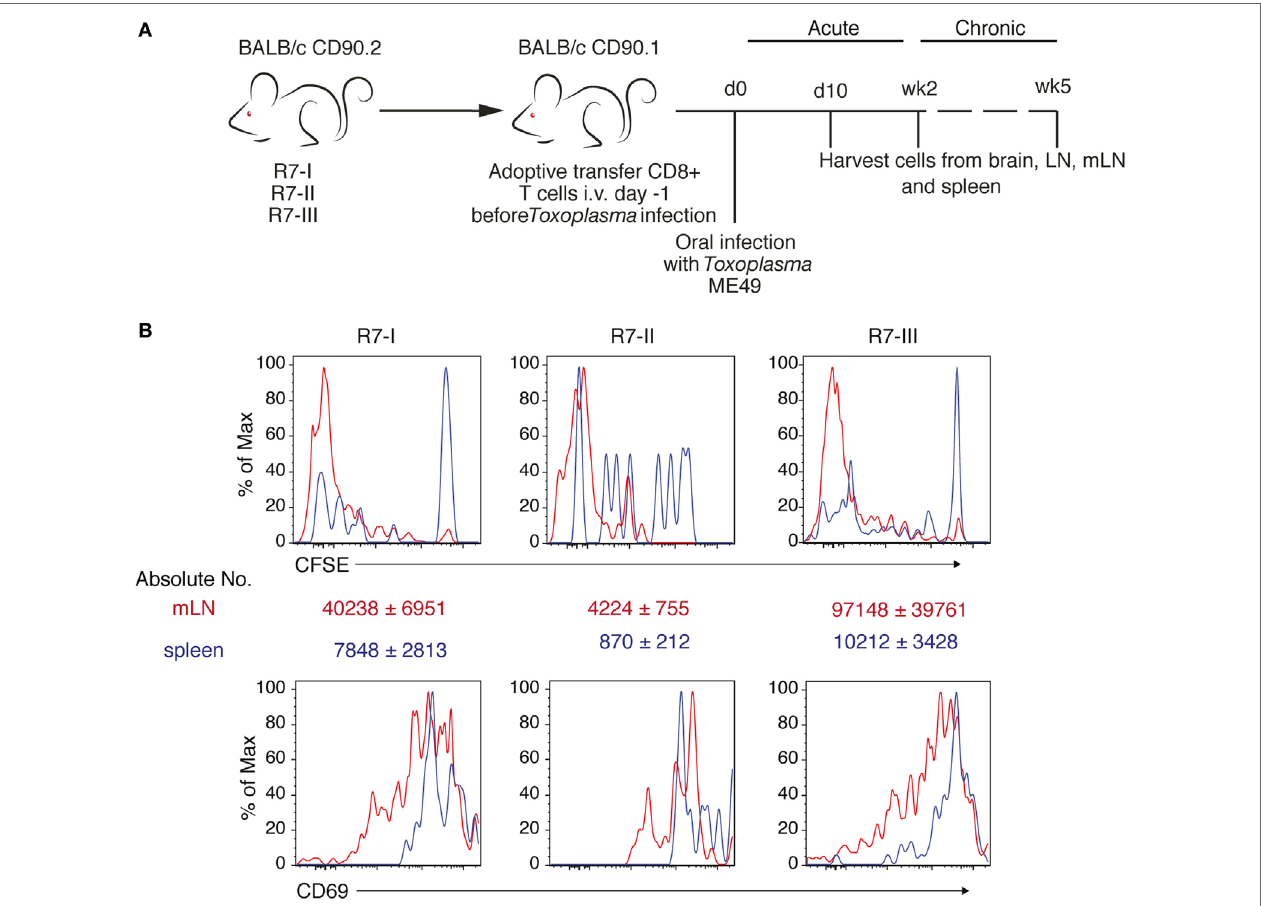
FigUre 2 | Three clones of R7-reactive CD8 T cells are primed and activated during the acute phase of Toxoplasma gondii infection. (a) Schematic diagram of the experimental setup for in vivo experiments. Transnuclear R7 mice were used as a donor of CD8 T cells in adoptive transfer experiments (AT). CD8 T cells isolated from lymph nodes (LN) and spleens were transferred to congenic recipients. Recipient mice were infected orally with five cysts of Toxoplasma ME49. At different time points post-infection (p.i.) recipient mice were sacrificed and donor CD8 T cell populations were assessed. (B) Donor cells were stained with CFSE before transfer. Histograms show CFSE dilution and CD69 expression on transferred R7 CD8 T cells isolated from mesenteric LN (mLN) 6 days p.i. via the oral route (representative of two independent